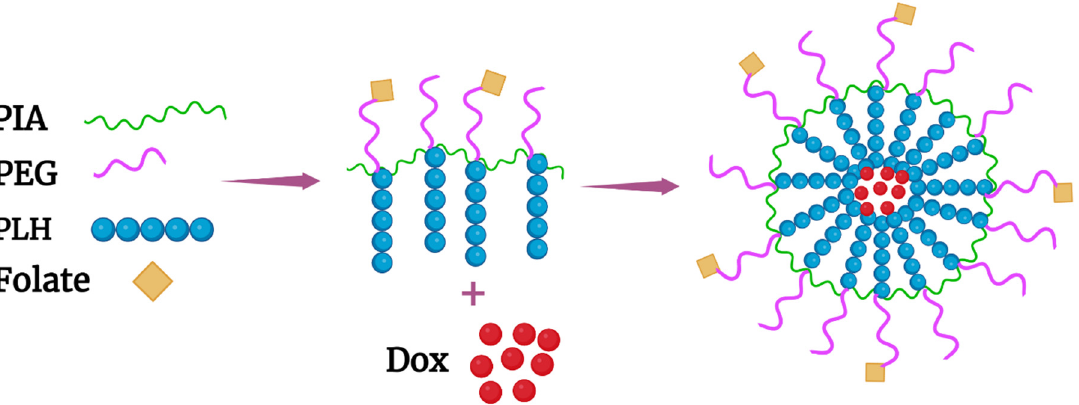
Figure 5. Schematic of the targeted graft polymer PIA-g-PEG-FA-g-PLH and the formed micelle. The pH-sensitive hydrophobic PLH domain entrapped Dox, whereas the folate-PEG ligand was on the exterior of the nanoparticle.